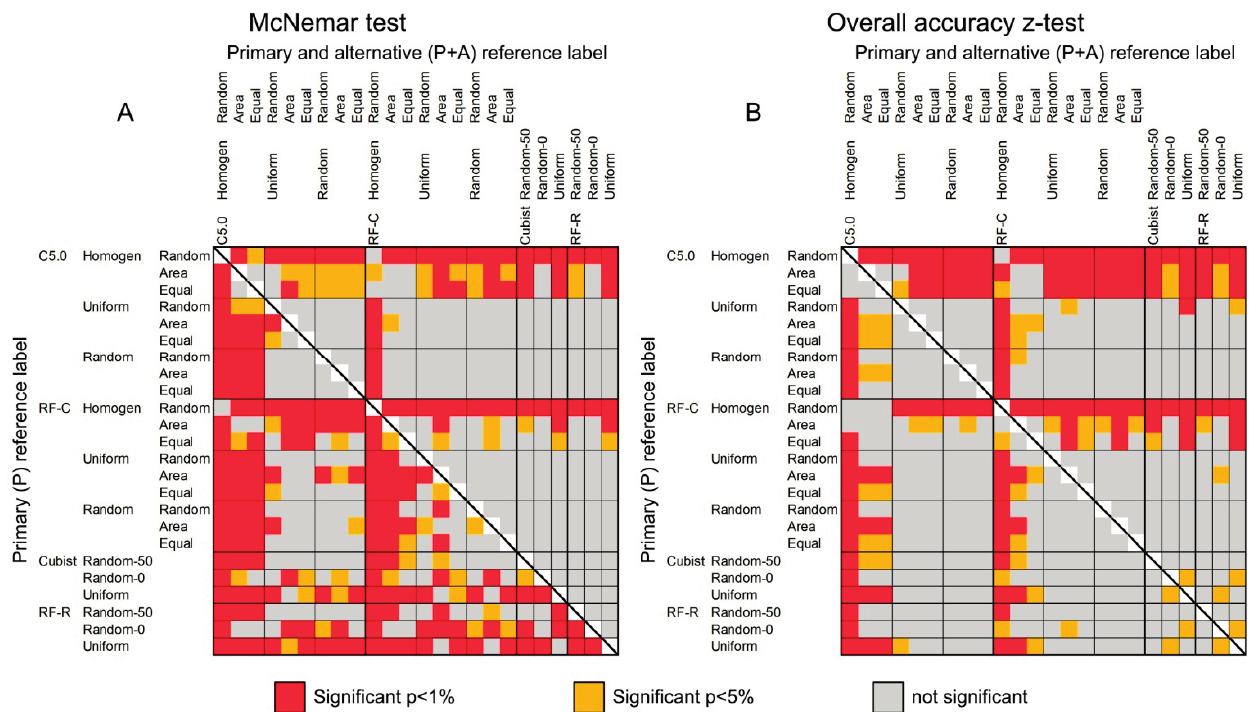
Figure 4. Statistical significance of difference in accuracies between ( A ) image classifications using McNemar test and ( B ) overall accuracies. Lower-left triangle shows results for the primary reference label, upper-right triangle for the primary and alternative reference label as correctly